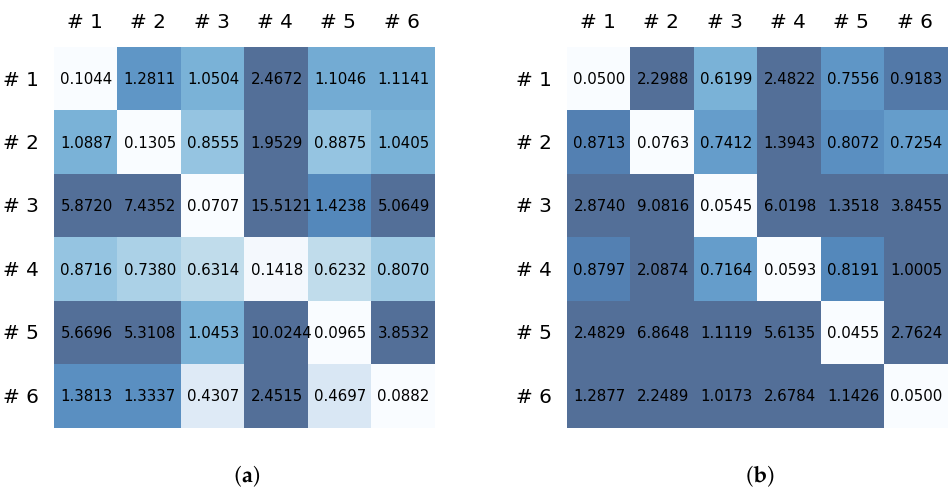
Figure 24. MSE values of the FNO model for ( a ) walking down stairs and ( b ) for walking up stairs.